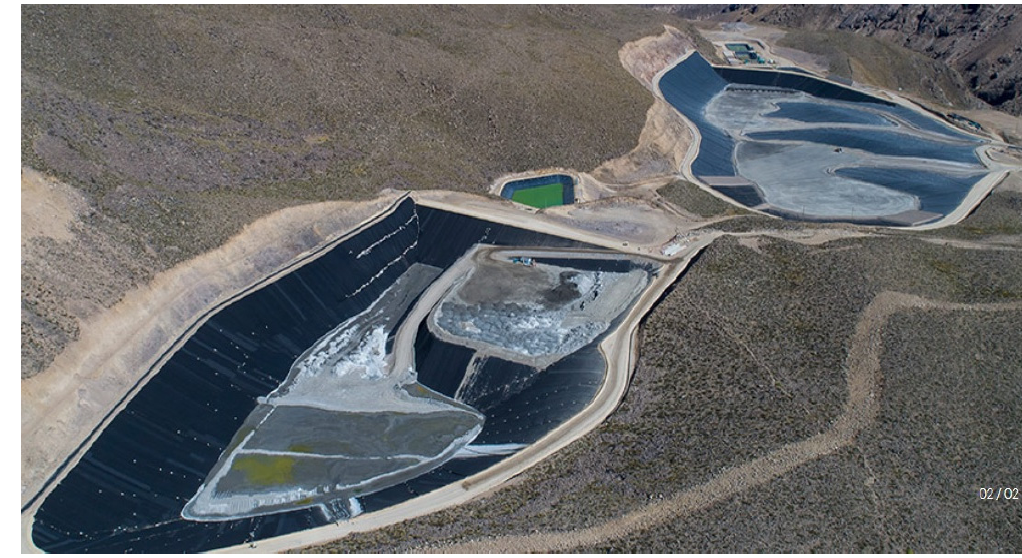
Figure 4. Gold mine tailings management—fully lined TSF—Tambomayo TSF, Peru [7].